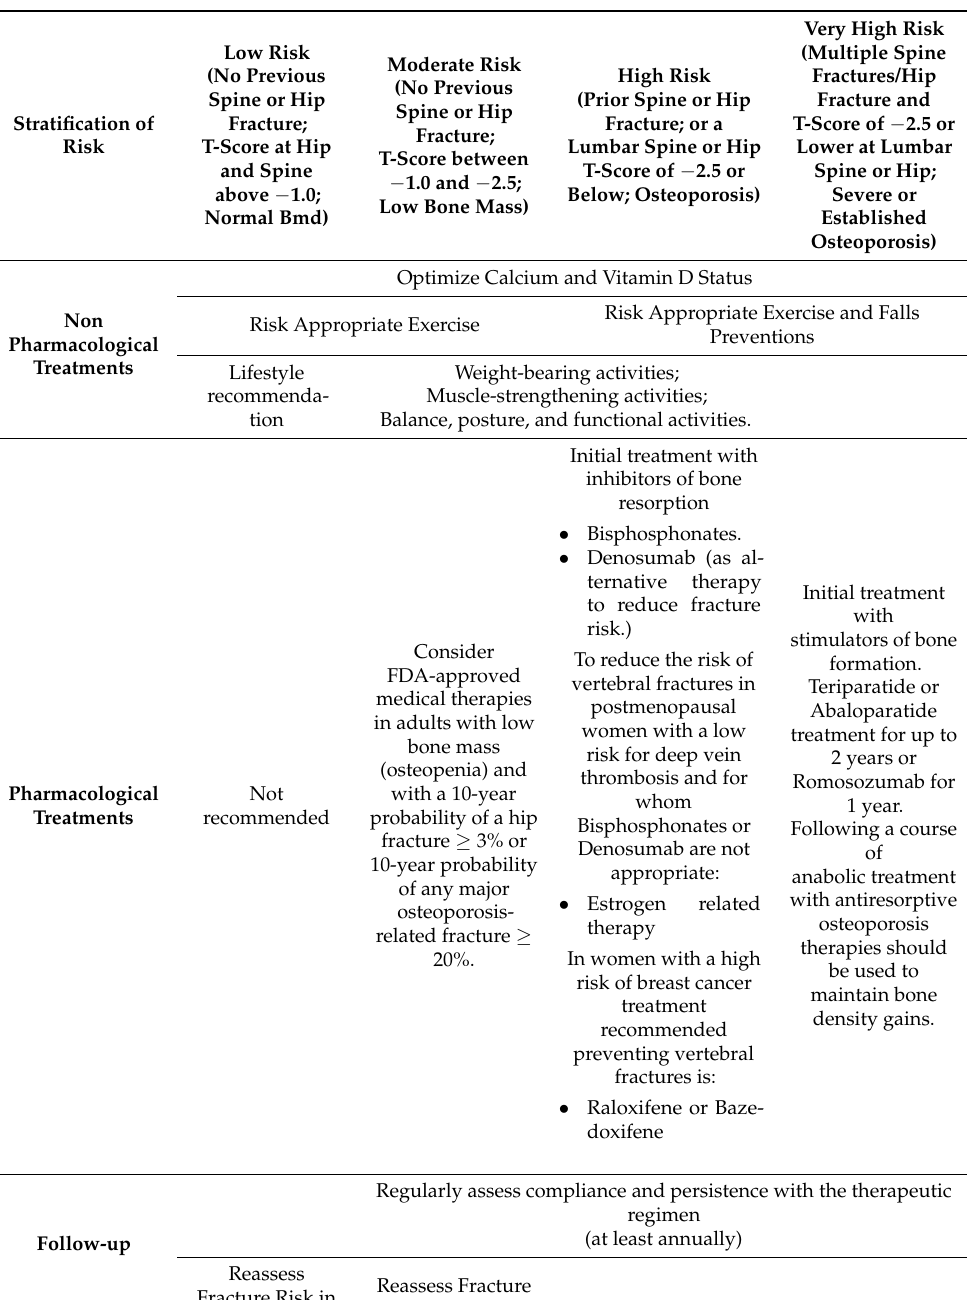
Table 2. Possible management of postmenopausal osteoporosis according to fracture